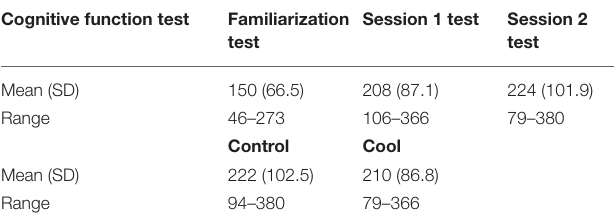
TABLE 2 | Mean (SD) Cognitive function results by order of test performed and Control vs.